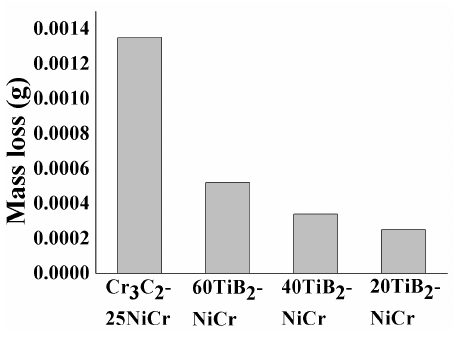
Figure 7. Mass loss of TiB 2 ‐ NiCr and Cr 3 C 2 ‐ 25NiCr coatings.